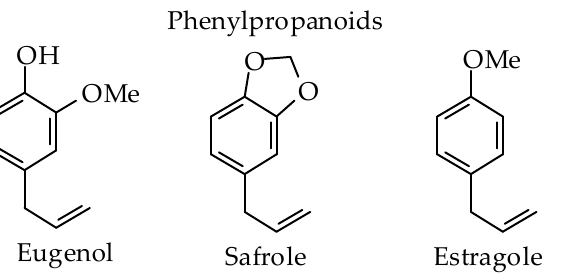
Figure 4. Chemical structures of the major components of essential oils from Cuba that were included in this study .